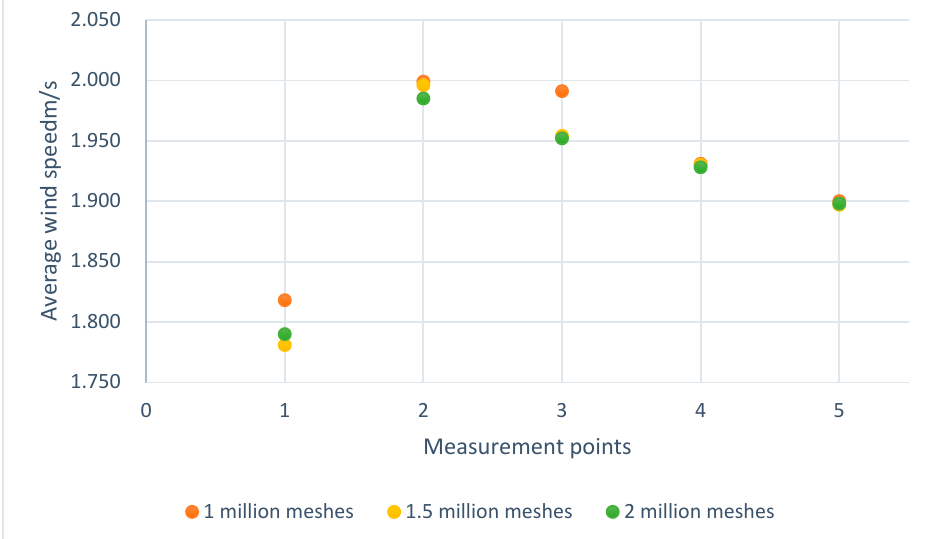
Figure 3. Grid independence verification.